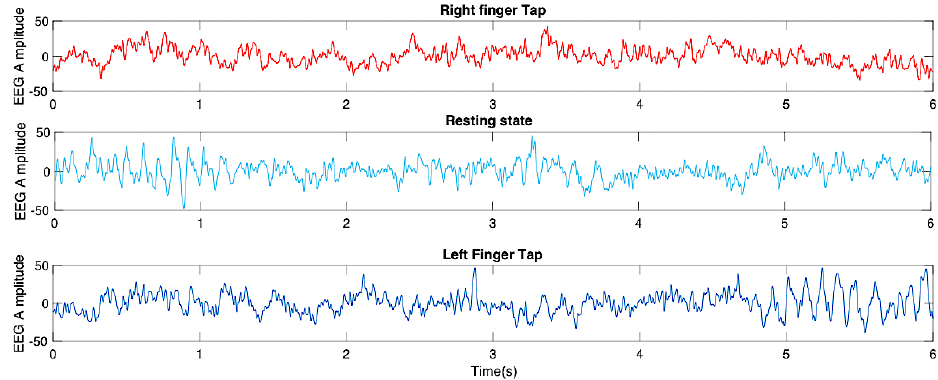
Figure 3. Part of the EEG signal for resting, left-hand, and right-hand stages of F3 channel for subject 1.